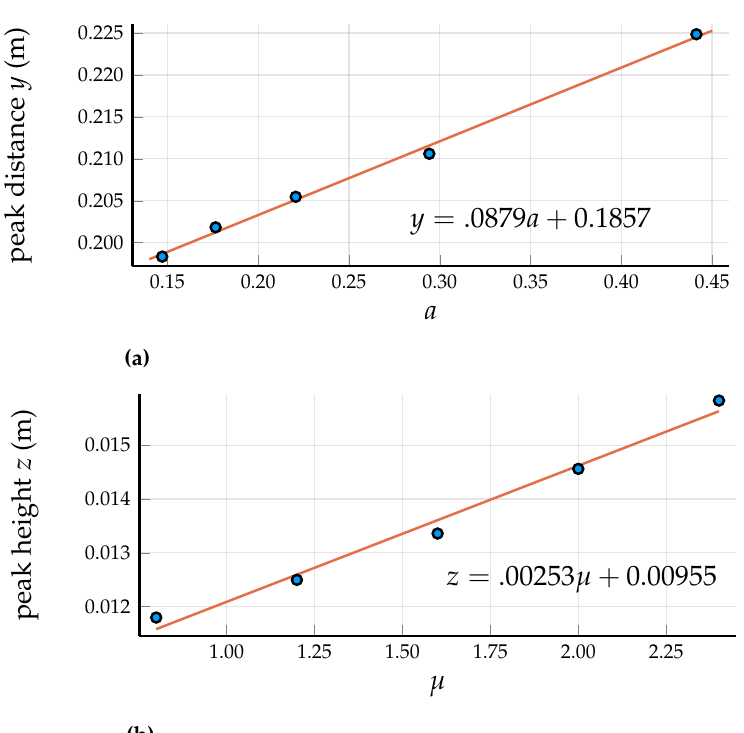
Figure 10. ( a ) A strong linear relationship is observed between the peak distance y and the parameter a , with a standard error of 0.0031m. ( b ) Peak undercut height as a function of µ . Standard error for the linear fit is 0.0018m. Both are measured from the baseline case when no modeled interface effects are